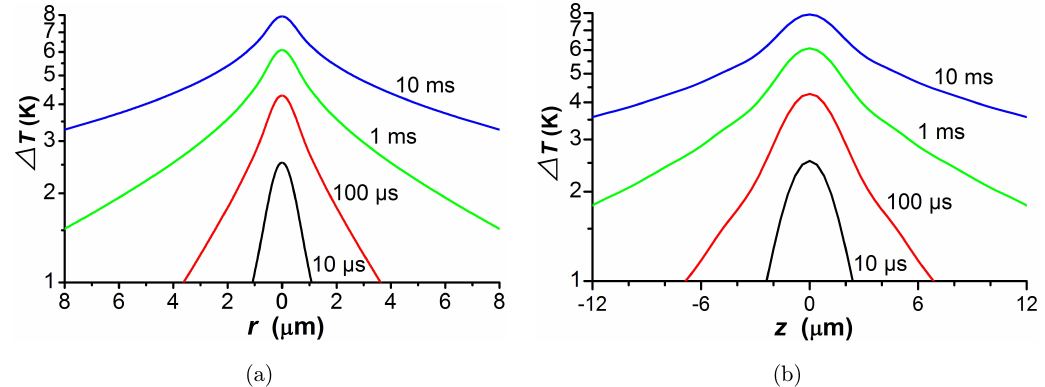
Fig. 4. Temperature rise after di®erent irradiation time along the radial (a) and axial (b) axes. The excitation light is 20 mW at 1700 nm. NA ¼ 1.05.